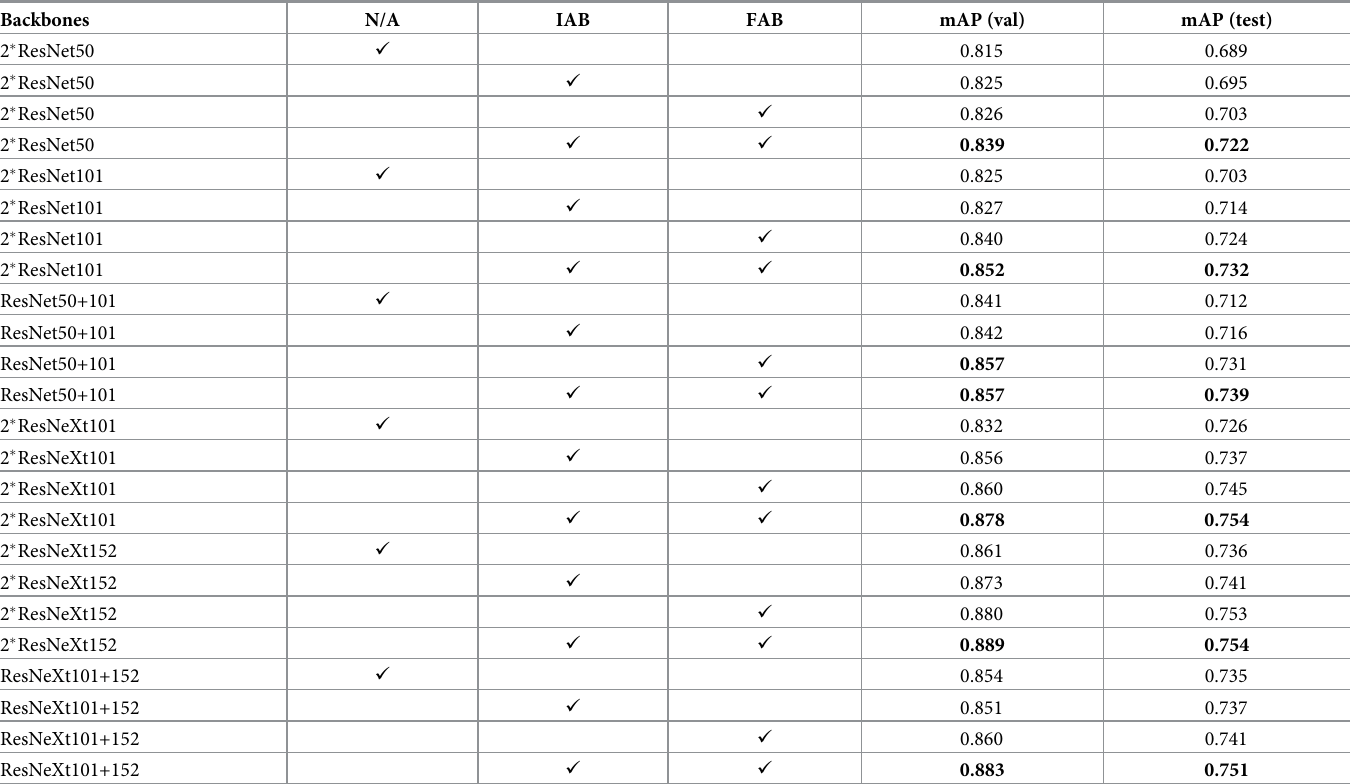
Table 5. The impact of the combination of image augmentation and feature augmentation